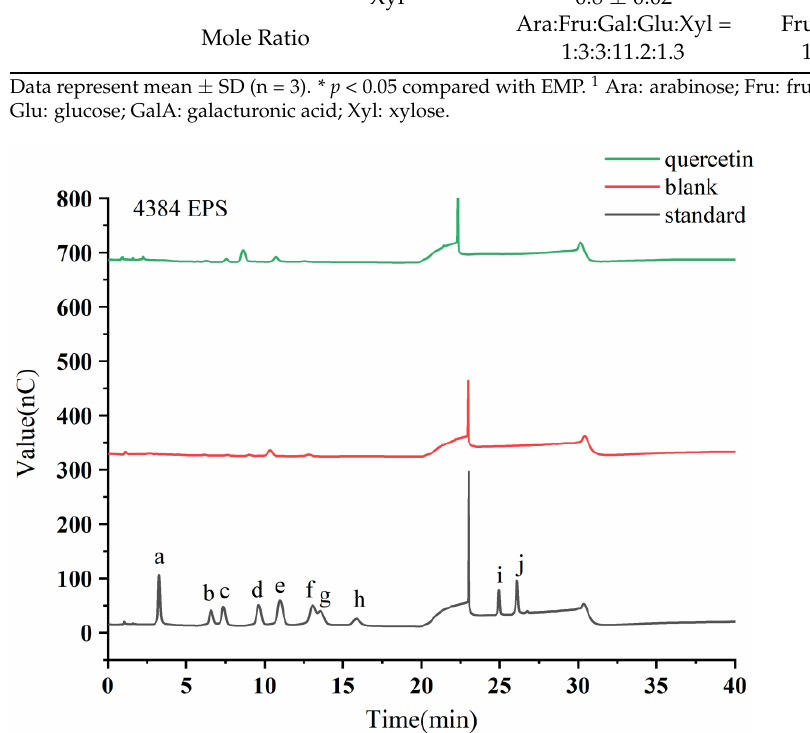
Figure 6. ( a ) Ability of EPS and Q-EMP to scavenge DPPH (2,2-diphenyl-1- picrylhydrazyl) free radicals. ( b ) Ability of EPS and Q-EMP to scavenge OH free radicals. ( c ) Ability of EPS and Q-EMP to scavenge ABTS free radicals. 3.8.2. -OH Scavenging Capacity The hydroxyl radical easily reacts with neighboring cells or biological molecules and causes serious oxidative damage to cells or biological molecules, leading to diseases such as aging and cancer [49]. From Figure 6b, when the concentration of EPS increased from 0.1 to 2.0 mg/mL, the ability of the blank group to eliminate -OH increased from 19.47%